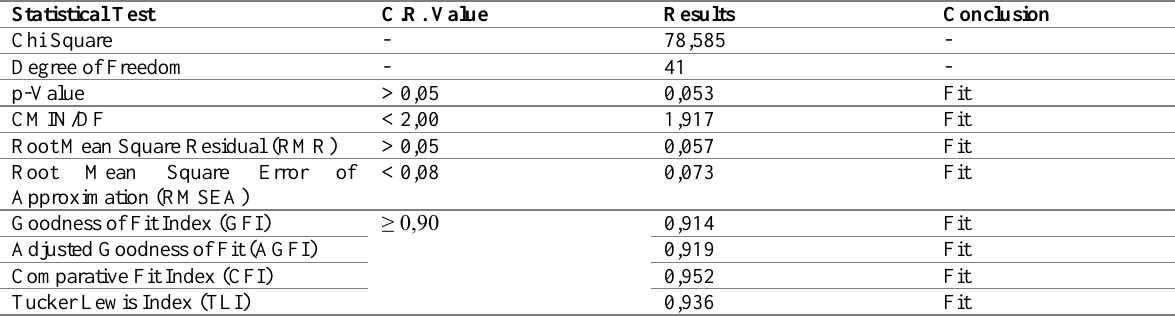
Table 3: Results of Model Fit Test